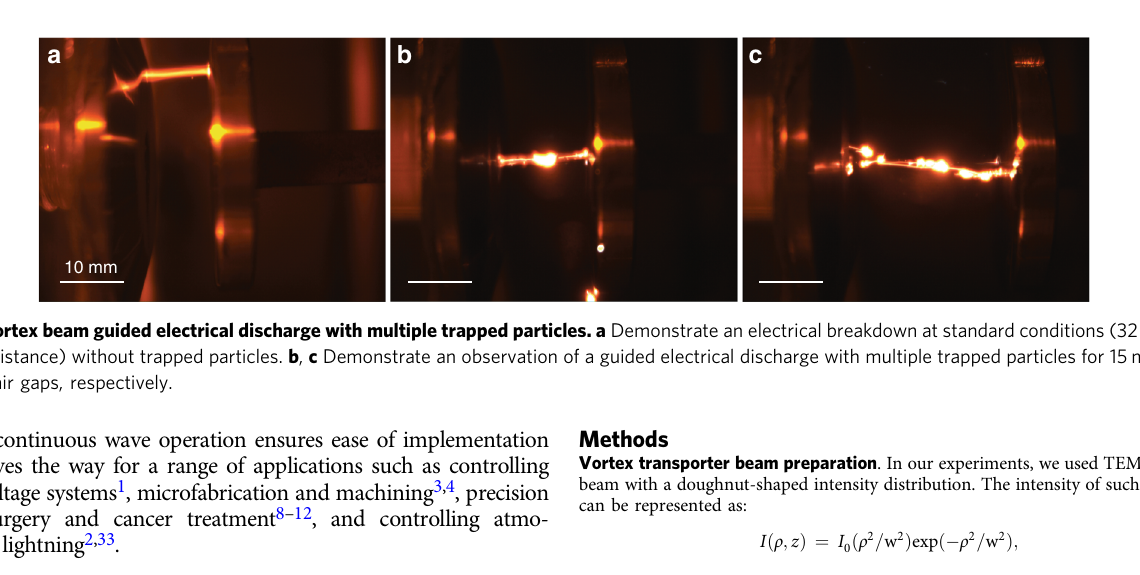
Fig. 4 Experimental study of the breakdown formation and discharge guidance. a , b CCD micrographs elucidating the role of a fi xed particle and its laser heating in the breakdown and discharge guidance: without any illumination at near-breakdown conditions the discharge follows random paths ( a ), whereas upon illumination ( b ) discharge is always guided through the particle. c , d Show the operation of a vortex transporter beam. With no particles trapped in the beam ( c ) discharge is not affected by the laser beam (cf. panel a ). However, when particles are trapped in the vortex beam and are brought between the electrodes, discharge always passes through the particles. In all of these cases, the voltage is 32 kV and the distance between electrodes is 10 mm, i.e., close to air-breakdown at normal conditions. A 532 nm CW laser with 500 mW power is used.